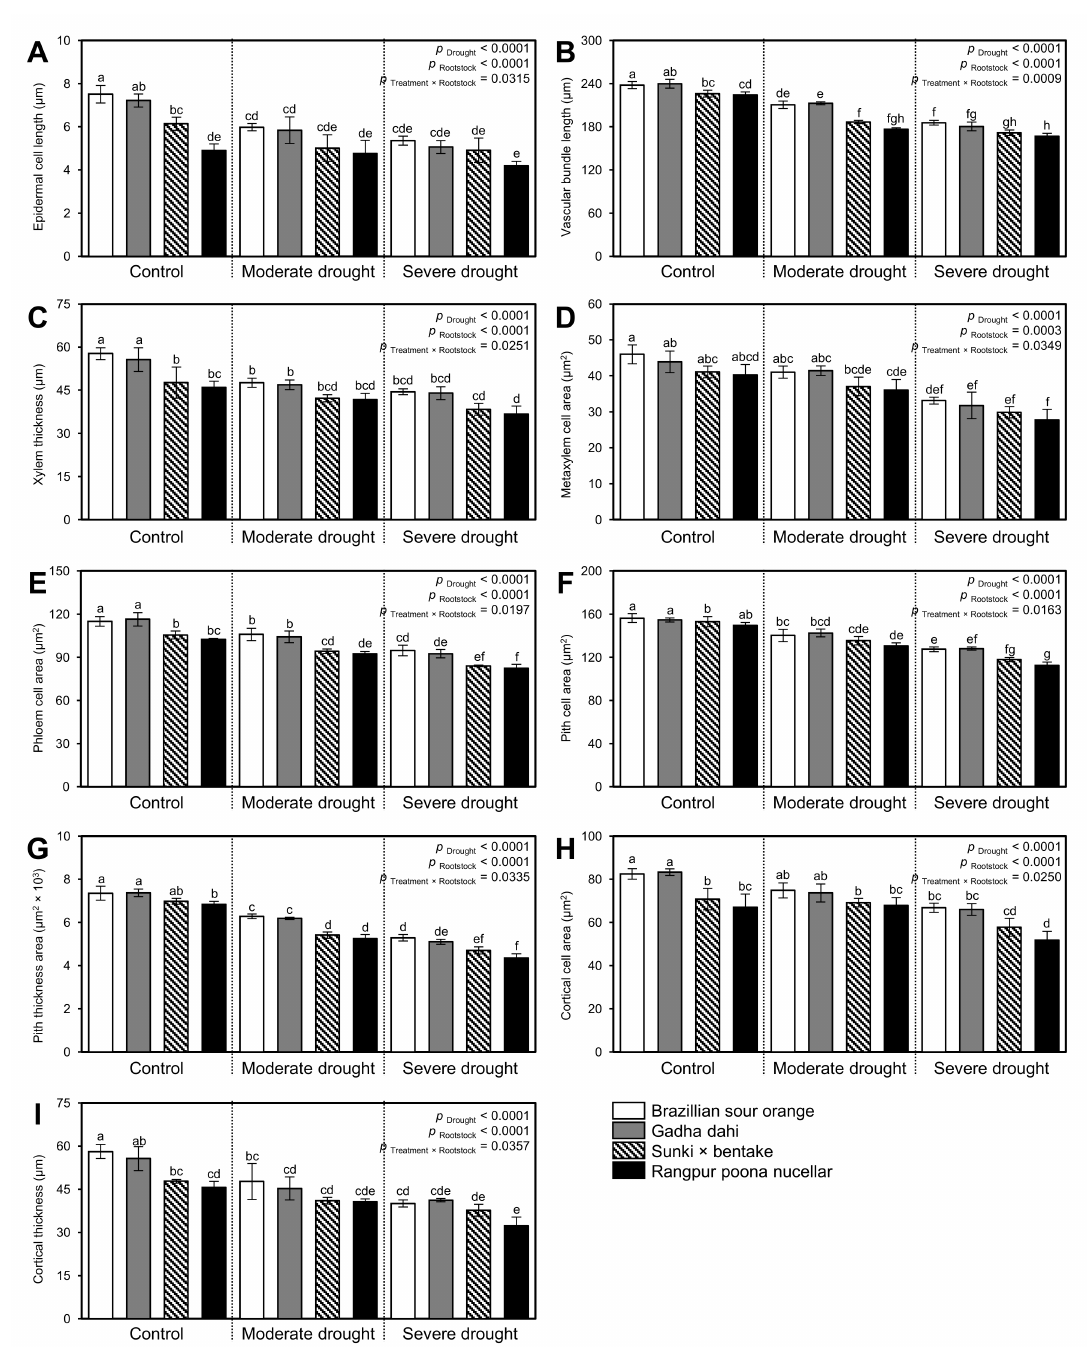
Figure 7. Effect of different water regimes on the leaf anatomical features of different two highly tolerant (Brazilian sour orange and Gadha dahi) and two highly sensitive genotypes (Rangpur Poona nucellar and Sunki × bentake). ( A ) Epidermal cell length ( µ m), ( B ) Vascular bundle length ( µ m), ( C ) Xylem thickness ( µ m), ( D ) Metaxylem cell area ( µ m 2 ), ( E ) Phloem cell area ( µ m 2 ), ( F ) Pith cell area ( µ m 2 ), ( G ) Pith thickness area ( µ m 2 × 10 3 ), ( H ) Cortical cell area ( µ m 2 ), and ( I ) Cortical thickness ( µ m). Data presented are means ± standard deviation (mean ± SD) of three biological replicates. Different letters indicate statistically significant differences among treatments, while “ns” signifies no significant differences between them according to Tukey’s honestly significant difference test ( p <